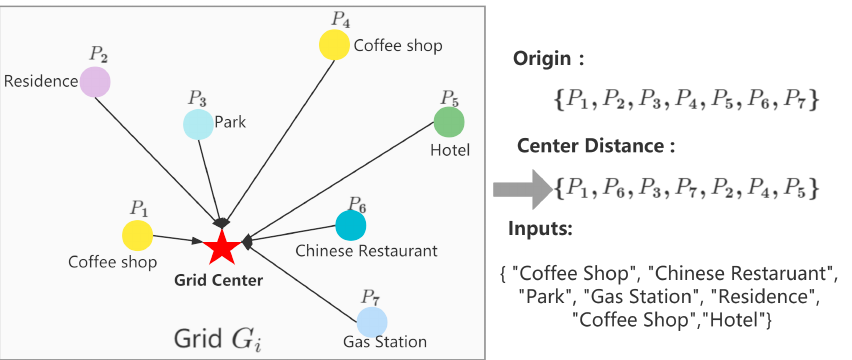
Figure 4. Construct a POI sequence based on distance ordering from the center